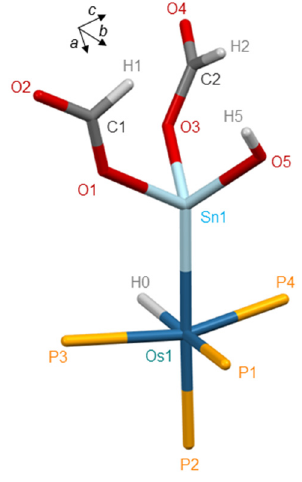
Figure 14. Molecular structure of 11 , adapted from [65] (MERCURY view). Ph and OEt substituents are omitted for clarity (Os blue, Sn light blue, O red, P orange, C grey, H white).